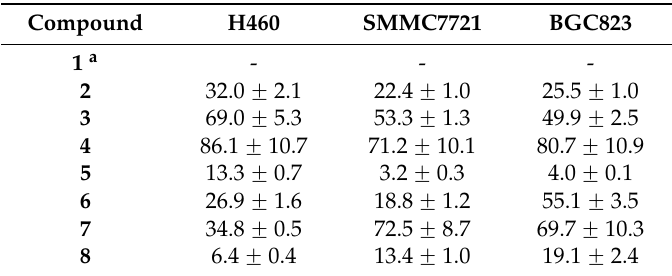
Table 1. The BPDs’ cytotoxicities against H460, SMMC7721, and BGC823 cell lines (IC 50 mean ˘ SD, µ g/mL) ( n = 3).